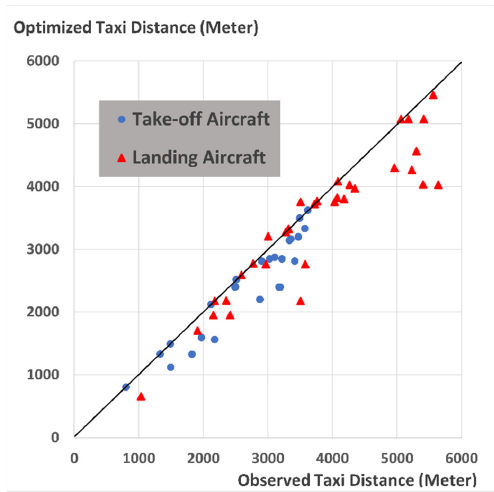
Figure 9. Result comparison of total taxi distance without runway reselection.